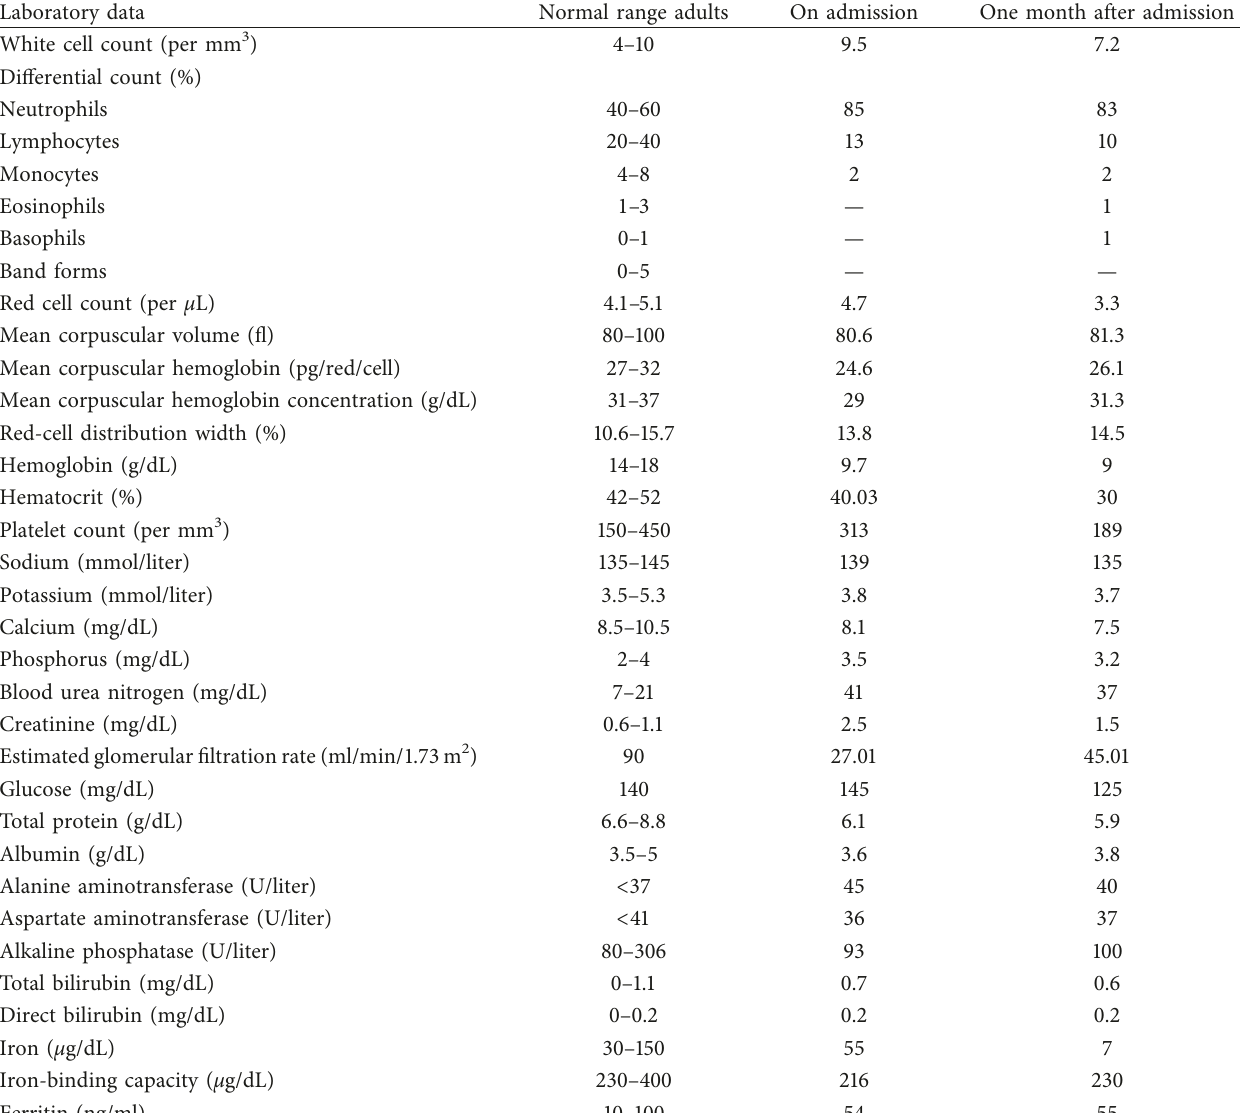
Table 1: Laboratory data on admission and one month